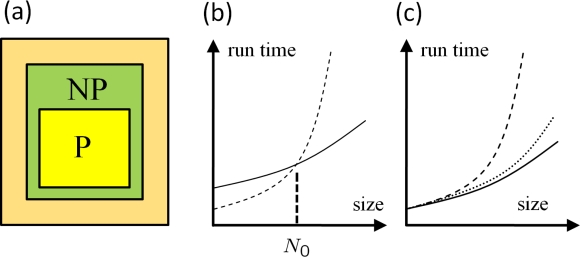
(a) Venn diagram of the class P (efficiently solvable problems), class NP (non-deterministic polynomial, i.e., inefficiently solvable problems), and undecidable problems (orange box) for which no algorithms are known. Today, it is generally assumed that all problems in P are contained in the class NP, cf. Figure 14. So far, no proof that decides whether P = NP or P ≠ NP is known. (b) An inefficient algorithm (dashed line) can – for some small values N up to an input number N0 – be more efficient than a polynomially bounded algorithm (solid line). (c) A real algorithm (dotted line) will always have a run time behavior somewhat in between the worst-case (dashed line) and best-case (solid line) run time.